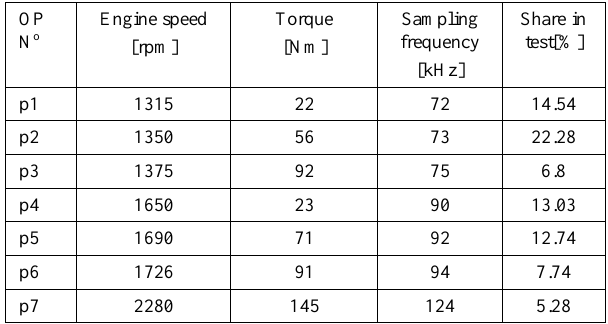
Table 4. Selected operation